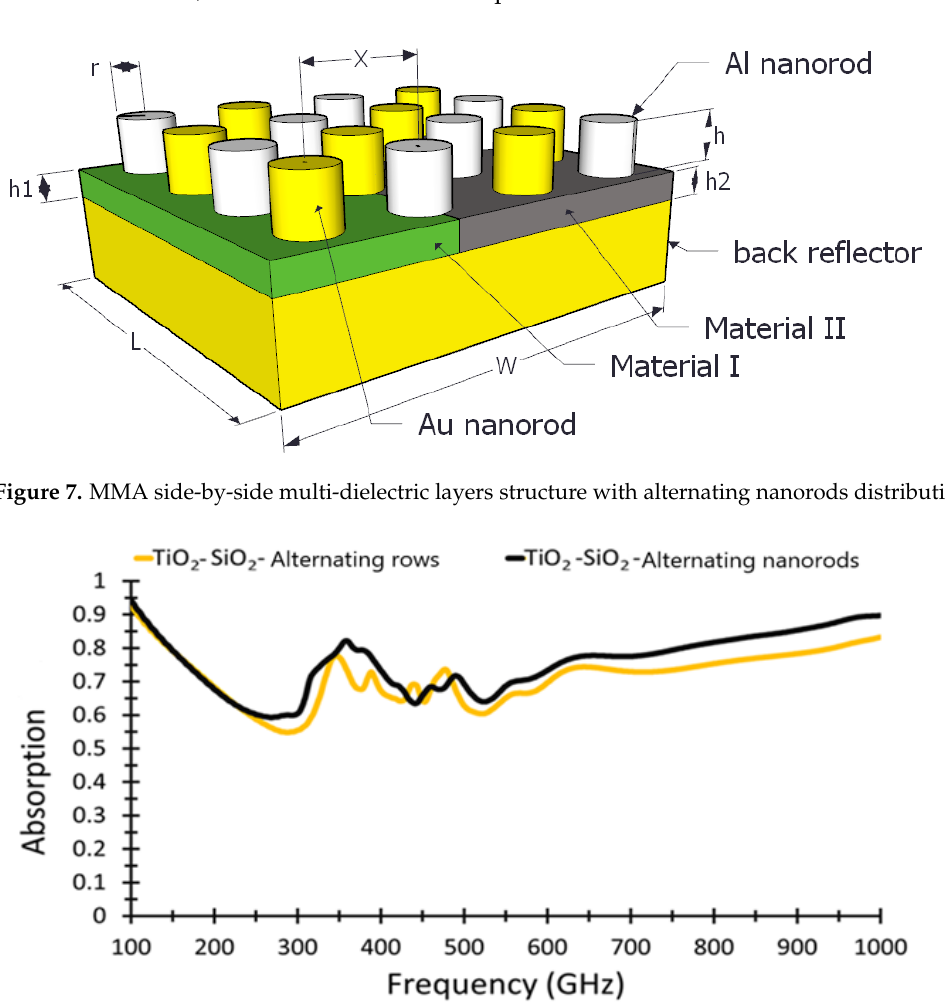
Figure 8. Absorption of the side-by-side multi-dielectric layers MMA structure with alternating rows of nanorods and alternating nanorods.